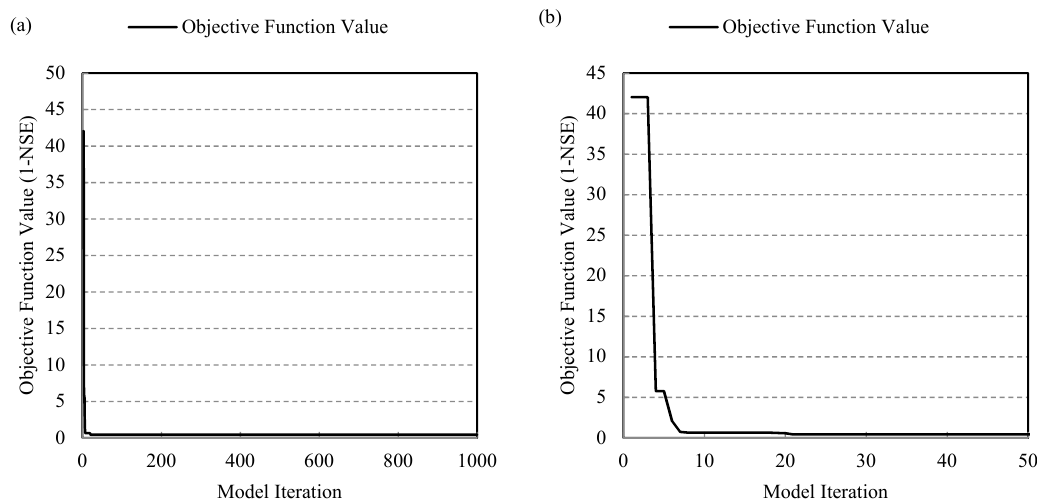
Figure 7. General model performance and the convergence of objective function values: ( a ) full calibration process of 1000 iterations; and, ( b ) closer look of the first 50 runs.